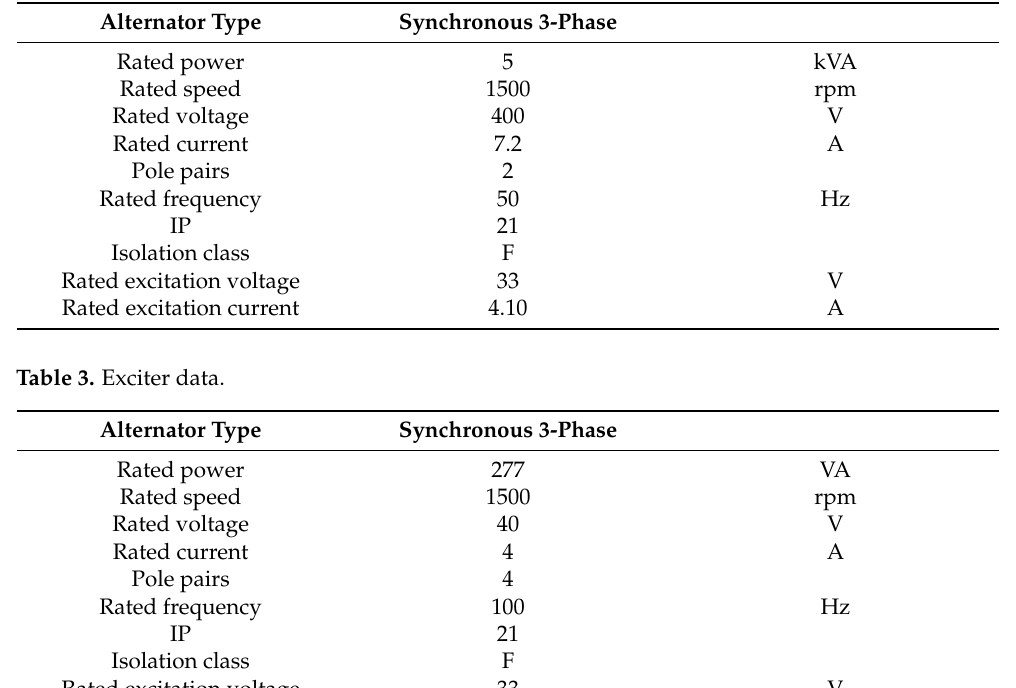
Figure 13. Experimental setup. ( a ) Induction motor; ( b ) generator; ( c ) diode bridge rectifier; ( d ) slip rings and brushes.